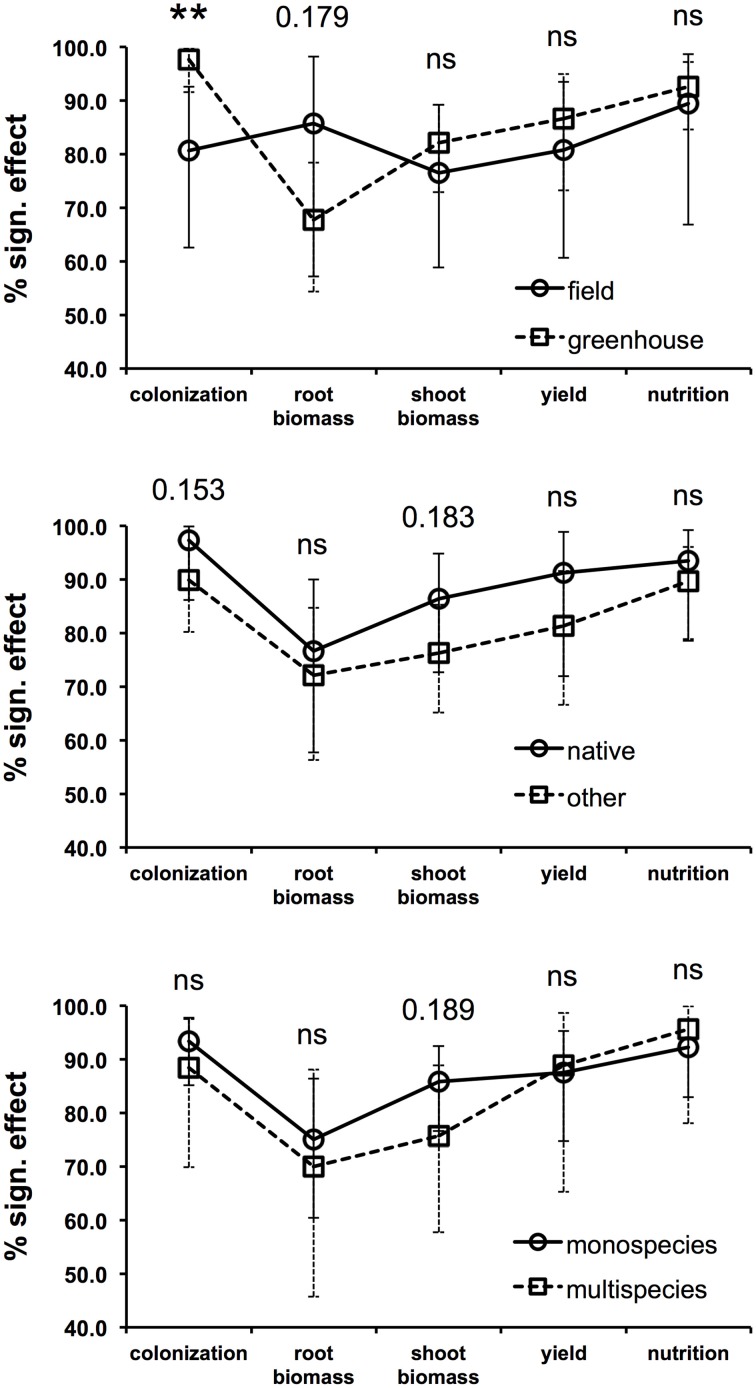
Percentage of experiments showing significant increases in fungal colonization, root biomass, shoot biomass, yield, and plant nutrition comparing field and greenhouse conditions (upper graph), inoculation with native AMF and AMF of different origin (center graph), and inoculation with only one species and multiple species at the same time (lower graph). The statistical significance of the difference between the two proportions (percentage value divided by 100) calculated for each factor (i.e., cultivation condition, inoculant origin, and method of application) was computed with a series of 2-sample z-tests. The z-test p-value is reported for each of the five parameters in each graph (**p < 0.01; ns = p > 0.20). The asymptotic confidence intervals are reported for each percentage value.